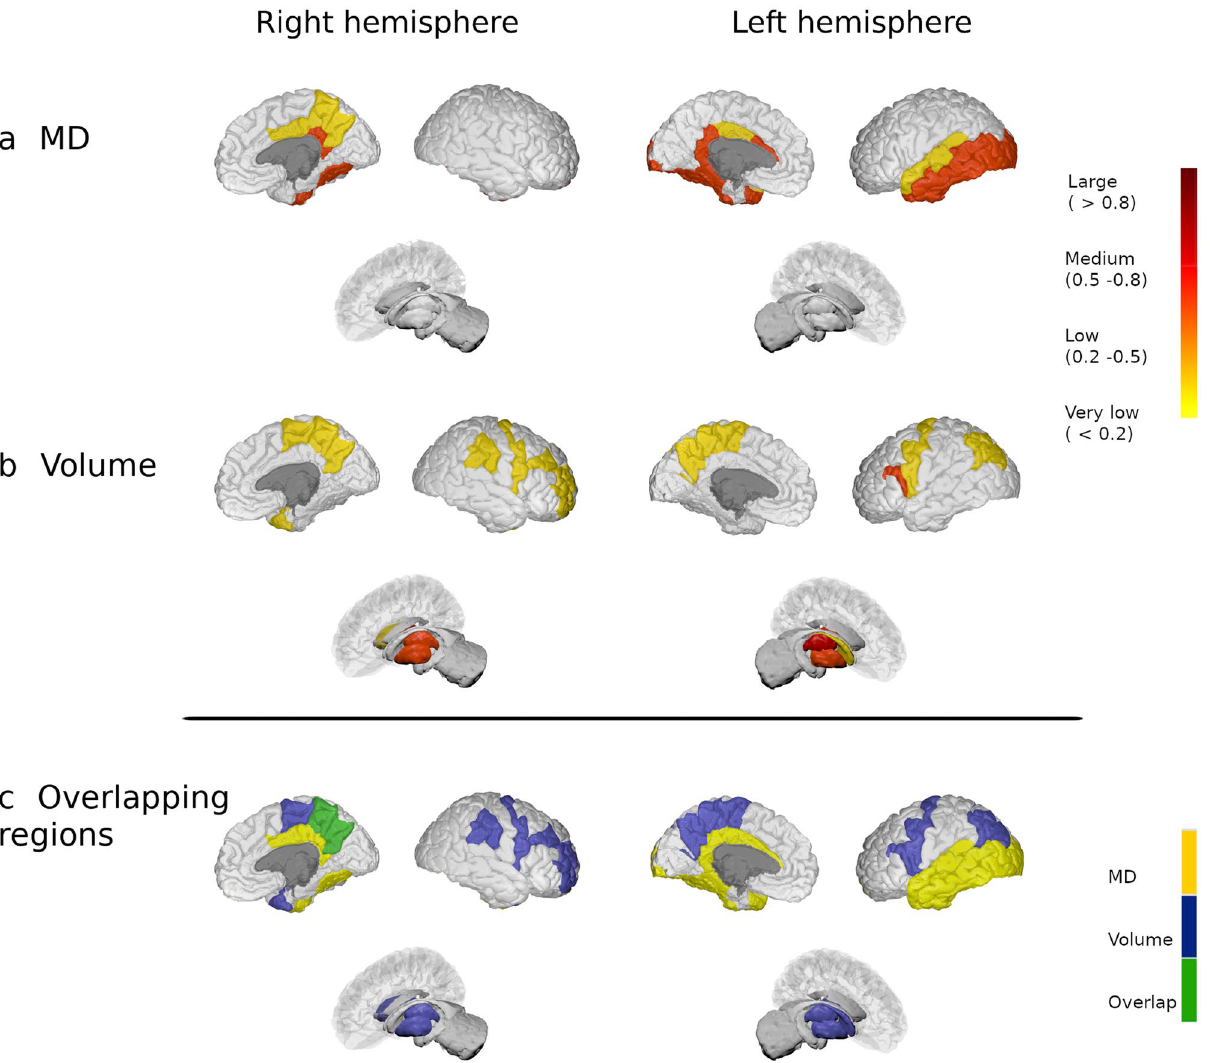
Figure 2. Modifications in patients with 5 to 15 years of disease duration. Differences in the grey matter mean diffusivity ( a ) and in volume ( b ) between MS patients from the MS2 group and HC. The colour gradient from yellow to red indicates the effect size ranges. The bottom figure shows the changes in MD (in yellow), volume (in blue) and their overlap (in green). The figure was generated using BrainPainter software 50